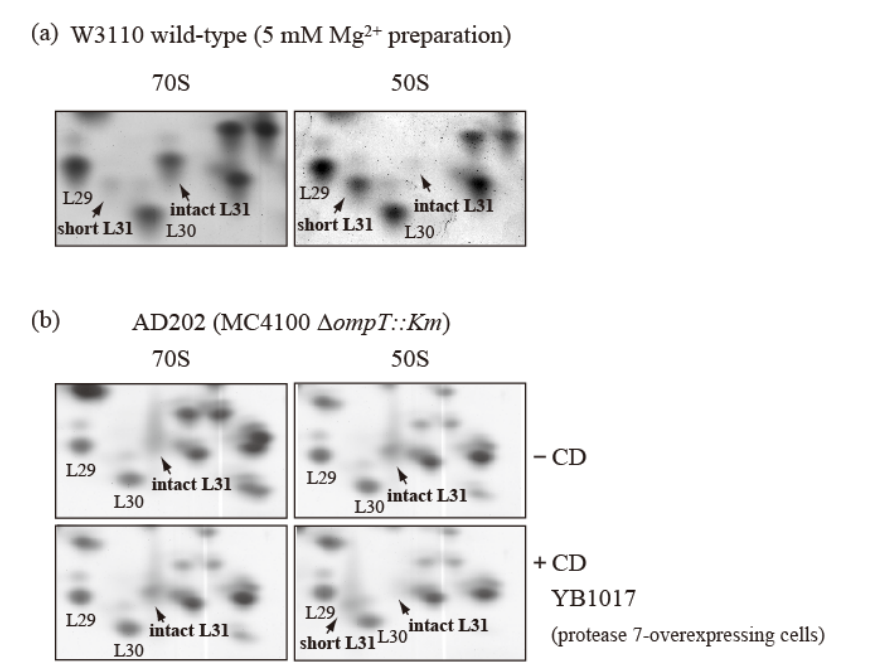
Figure 6. bL31 is accessible for cleavage by protease 7 when it is associated with the free 50S subunit but not when it is associated with the 70S ribosome. ( a ) 70S and 50S of W3110 cells prepared using a buffer containing 5 mM Mg 2+ contain only intact and short bL31s, respectively. W3110 cells were grown at 37 °C in EP medium and collected in the exponential growth phase (Klett units: 50). CRs were prepared using the standard methods, except that buffer I was modified to contain 5 mM Mg 2+ . CRs were fractionated via 10–40% SDG centrifugation in the presence of 5 mM Mg 2+ , and 50S and 70S fractions were collected. Each fraction was analyzed using RFHR 2D PAGE. Relevant gel areas of bL31 are shown. ( b ) bL31 is more accessible for cleavage by protease 7 in free 50S than in 70S. Δ ompT::Km (AD202) cells were grown at 37 °C in EP medium and collected in the exponential growth phase (Klett units: 50), and HSRs were prepared as the 70S fraction. HSRs were dialyzed against dissociation buffer I (20 mM Tris-HCl (pH 7.6), 1 mM magnesium acetate, 100 mM ammonium acetate, and 6 mM 2-mercaptoethanol) overnight. The sample was fractionated by means of 10–40% SDG centrifugation in dissociation buffer I, and the 50S fraction was collected. The 50S and 70S fractions exclusively contained intact bL31. CD was prepared from protease-7-overproducing W3110 (YB1017) cells and added to the 50S and 70S fractions. Each mixture (50S ± CD and 70S ± CD) was incubated at 37 °C for 30 min. Subsequently, proteins in the four samples were analyzed using RFHR 2D PAGE. Relevant gel areas of bL31 are shown. Spots corresponding to r-proteins bL29, bL30, intact bL31, and short bL31 are indicated. In Figure 6, the “b” of r-proteins is omitted.